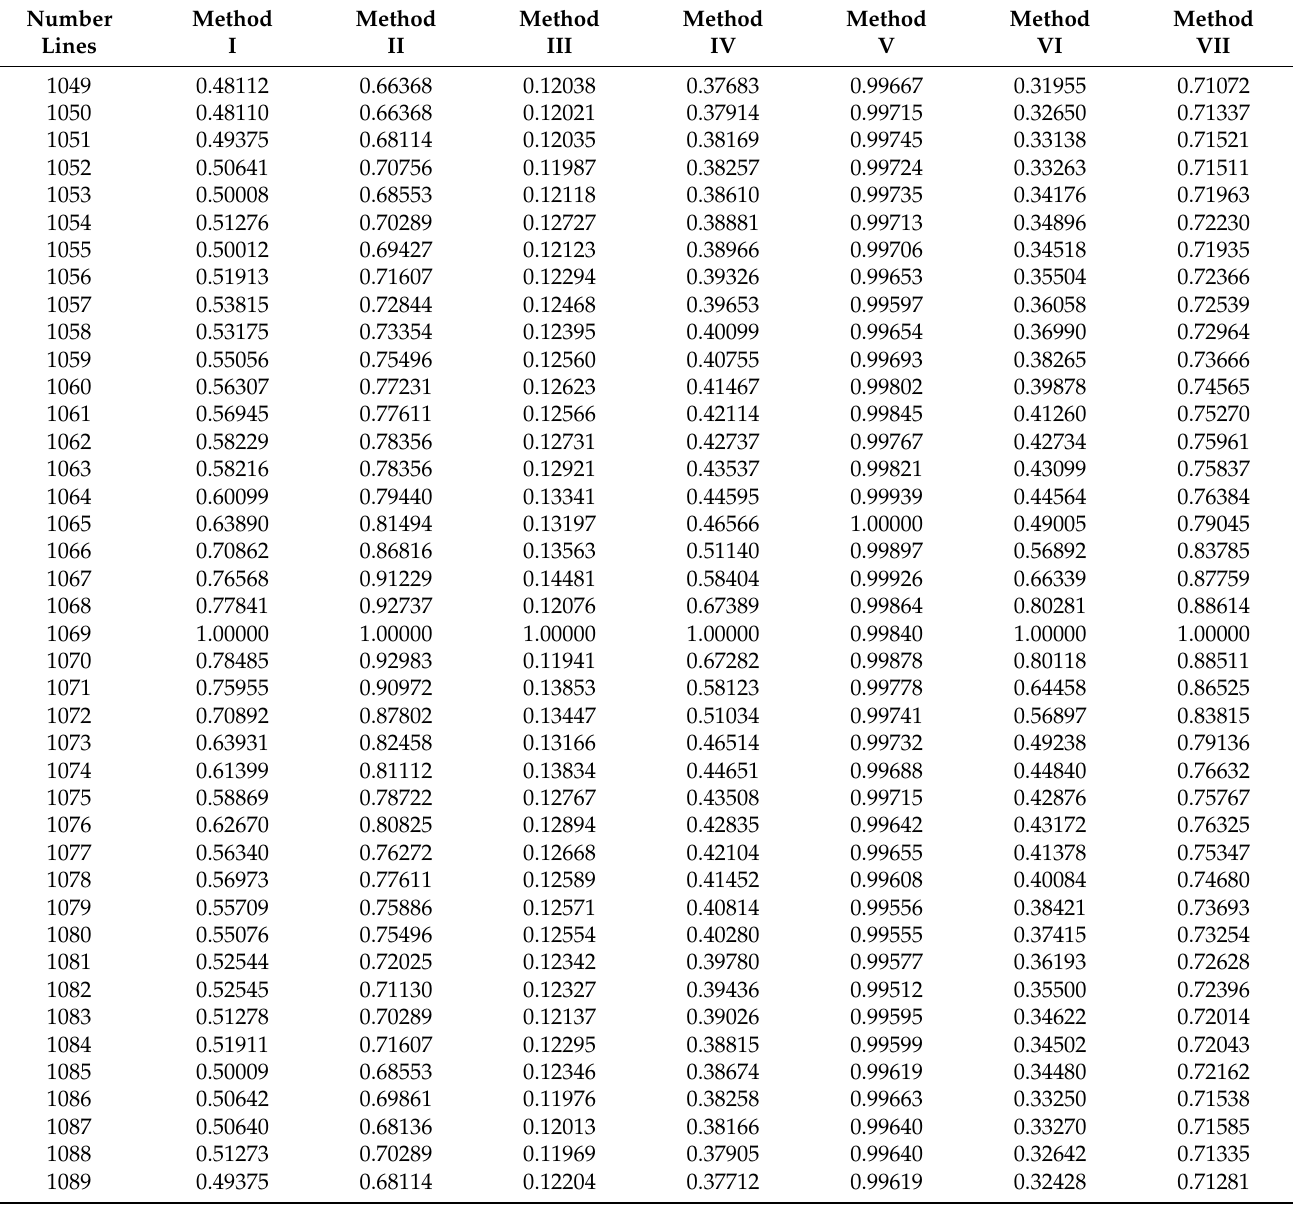
Table 1. Normalized values (in relation to the maximum value) of the variability of measures as a function of the number of image lines, supporting the determination of the correct number of lines of the image reproduced for the source image in the form of a picture from Figure